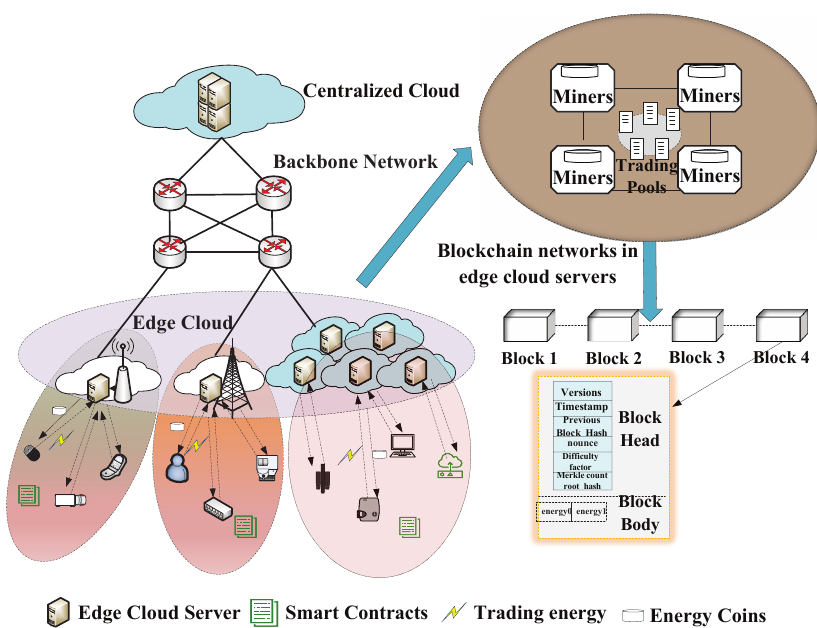
Figure 1. Blockchain-based energy trading framework at the Edge of the Internet of